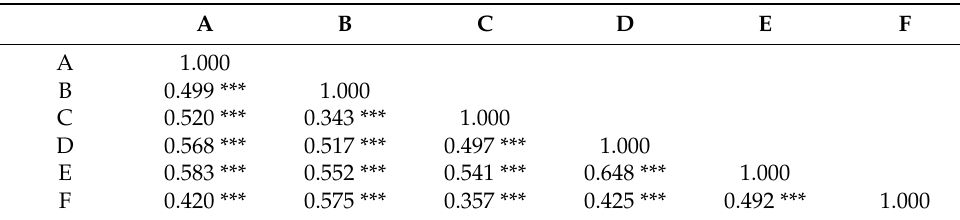
Table 5. Correlation analysis of health perception performance.